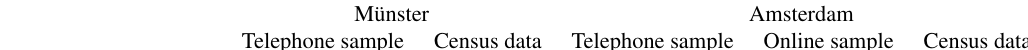
Table 3. Basic statistics of the data sets. City-level census data are obtained from the databases of LfStat (2017b) and Statistics Netherlands (2017) for Münster and Amsterdam respectively. Characteristics of people relate to persons older than 15